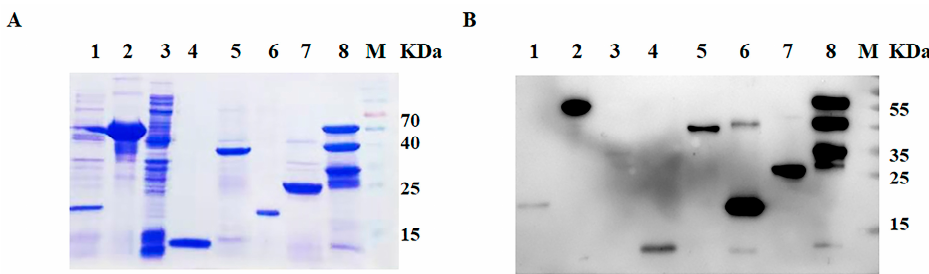
Figure 1. Purification and identification of SVA protein. ( A ) SDS-PAGE. ( B ) Western blot. Lane 1 is the pET-32a (m) control, lane 2 is the VP1 recombinant protein, lane 3 is the pET-28a control, lane 4 is the L recombinant protein, lane 5 is the 2C recombinant protein, lane 6 is the 3AB recombination protein, lane 7 is the 3C recombinant protein and lane 8 is the 3D recombinant protein. M is the protein ladder. The order was the same in ( A , B ).